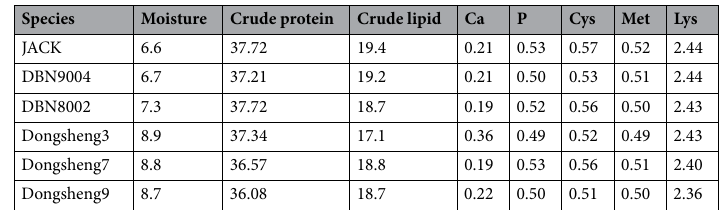
Table 2. Nutrient composition of six types of soybean feed ( X ± s , %).